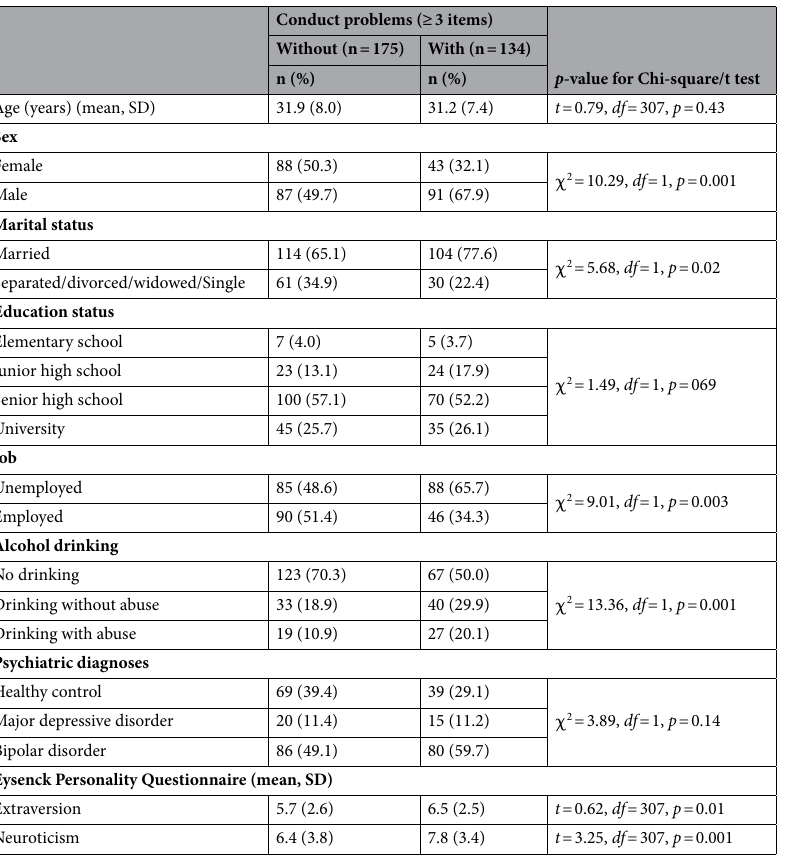
Table 2. Sociodemographic and clinical characteristics of participants (n =